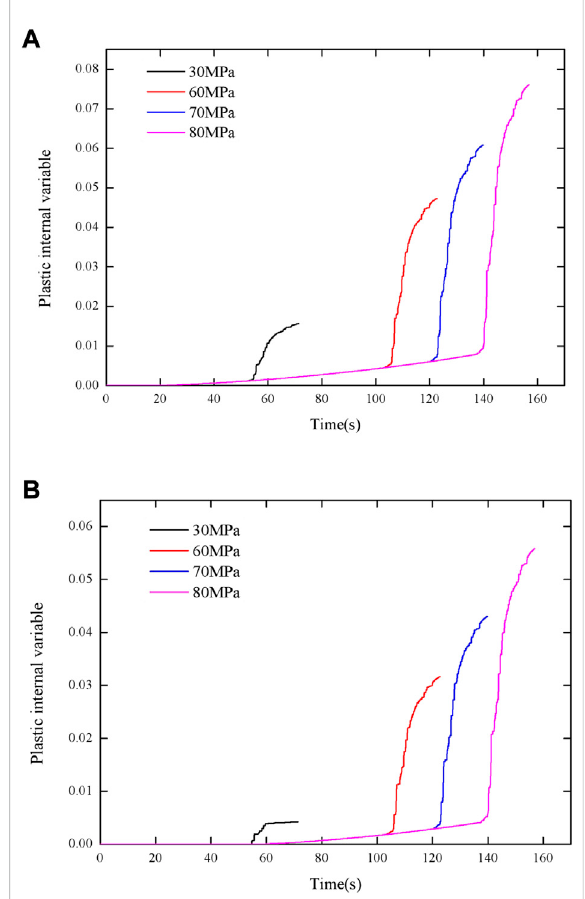
FIGURE 7 The variation in plastic internal variable of the rock under Kobe seismic load with different maximum stresses: (A) Triaxial loading with con fi ning pressure of 5 MPa; (B) Triaxial loading with con fi ning pressure of 15